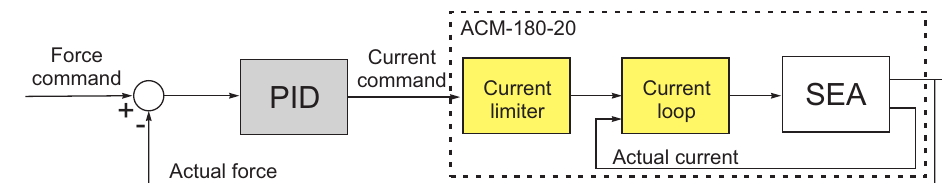
Figure 20. Joint force control based on a